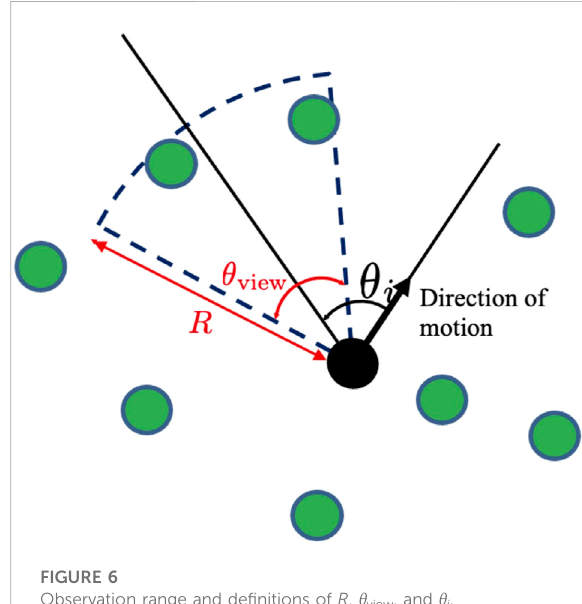
FIGURE 6 Observation range and de fi nitions of R , θ view , and θ i